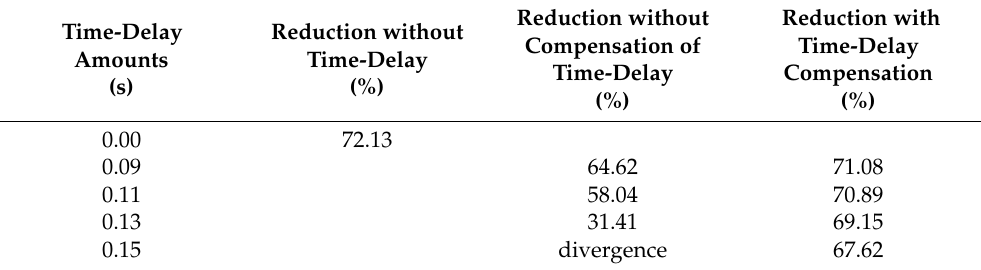
Table 3. Response reduction at mid-span of three control strategies under harmonic excitation.